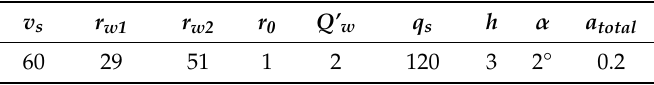
Table 3. Grinding conditions of the progressive grinding